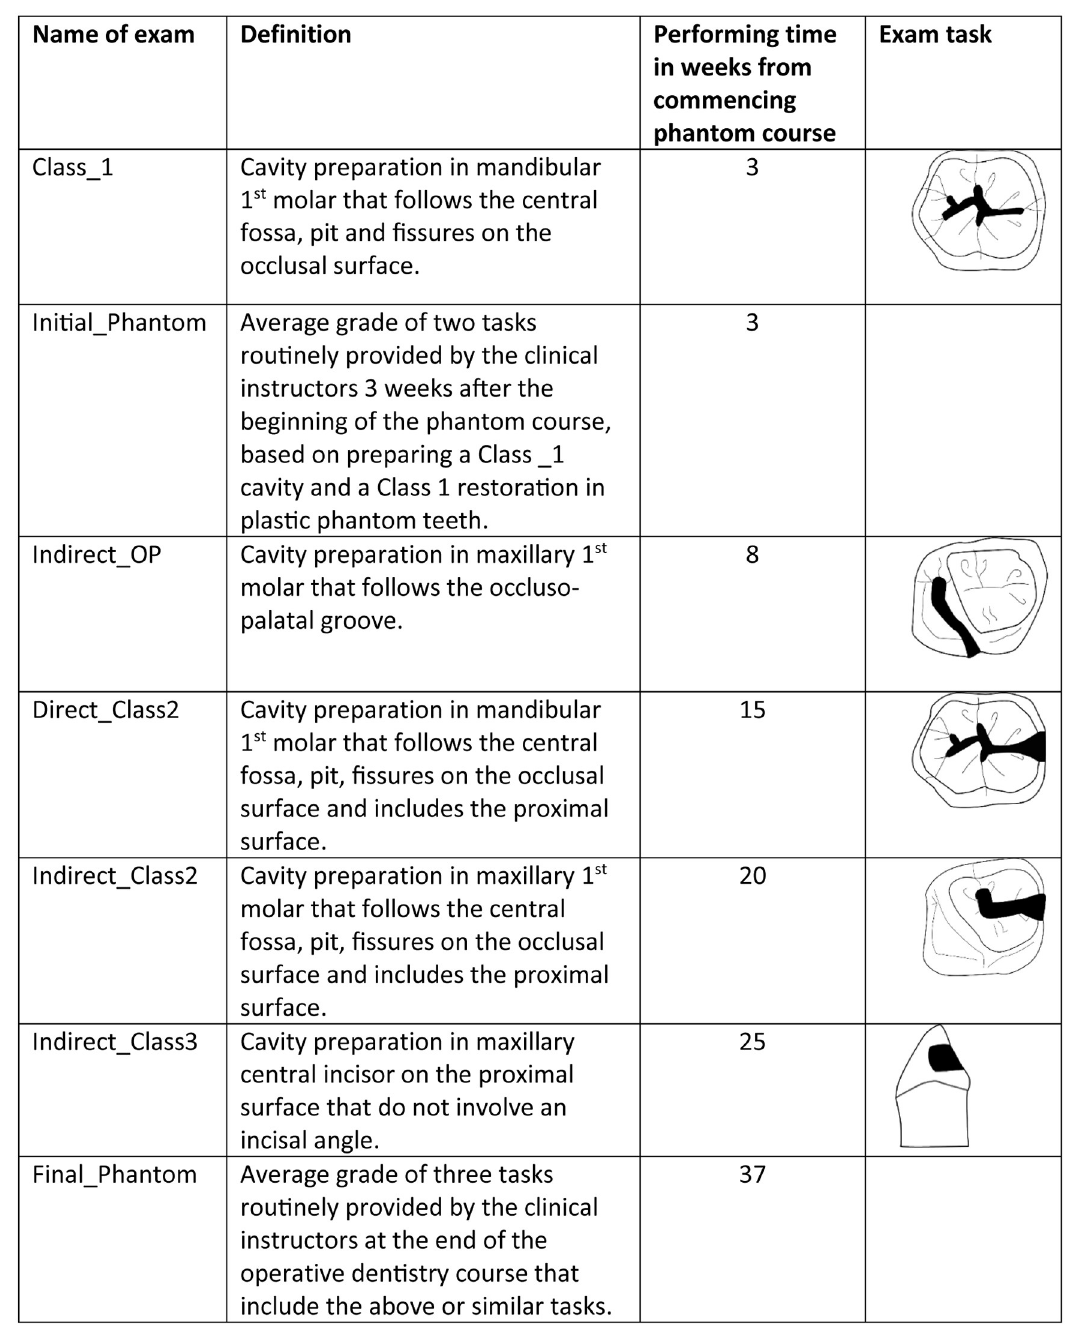
Fig 2. Time table and illustration of the exams’ tasks along the phantom